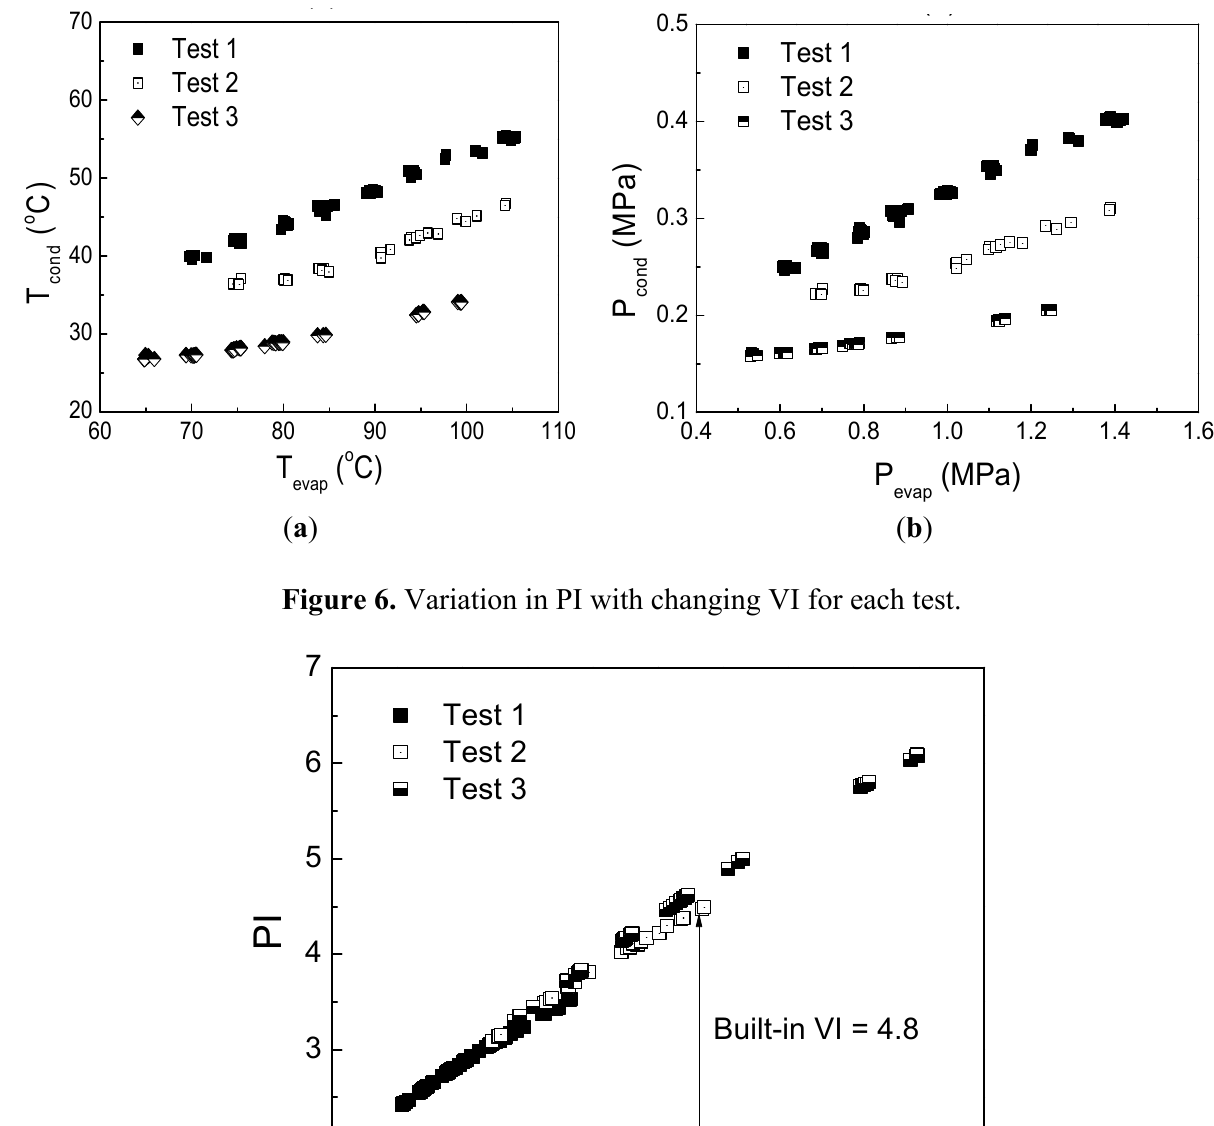
Figure 5. Plots of ( a ) T cond vs . T evap and ( b ) P cond vs . P evap for the three tests.